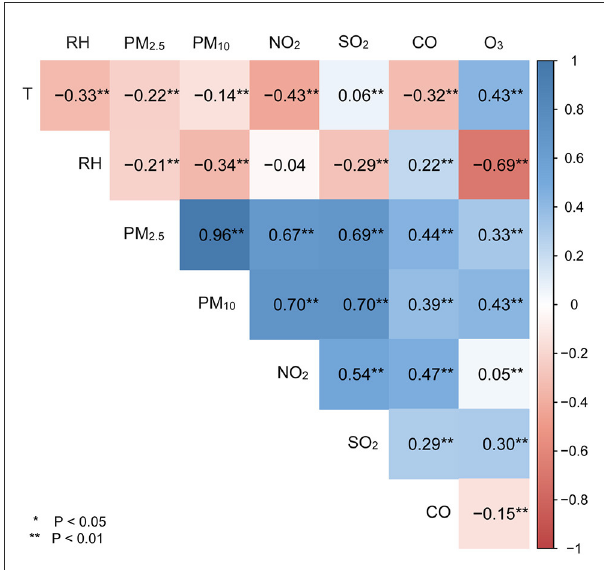
FIGURE1 Spearman’s rank correlations of meteorological variables with ambient air pollutants. T represents temperature; RH denotes relative humanity; *means P < 0.05, **means P < 0.01.